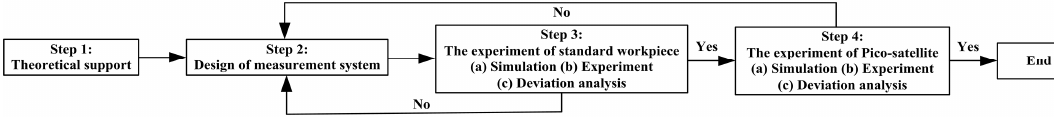
Figure 1. A summary of the paper.